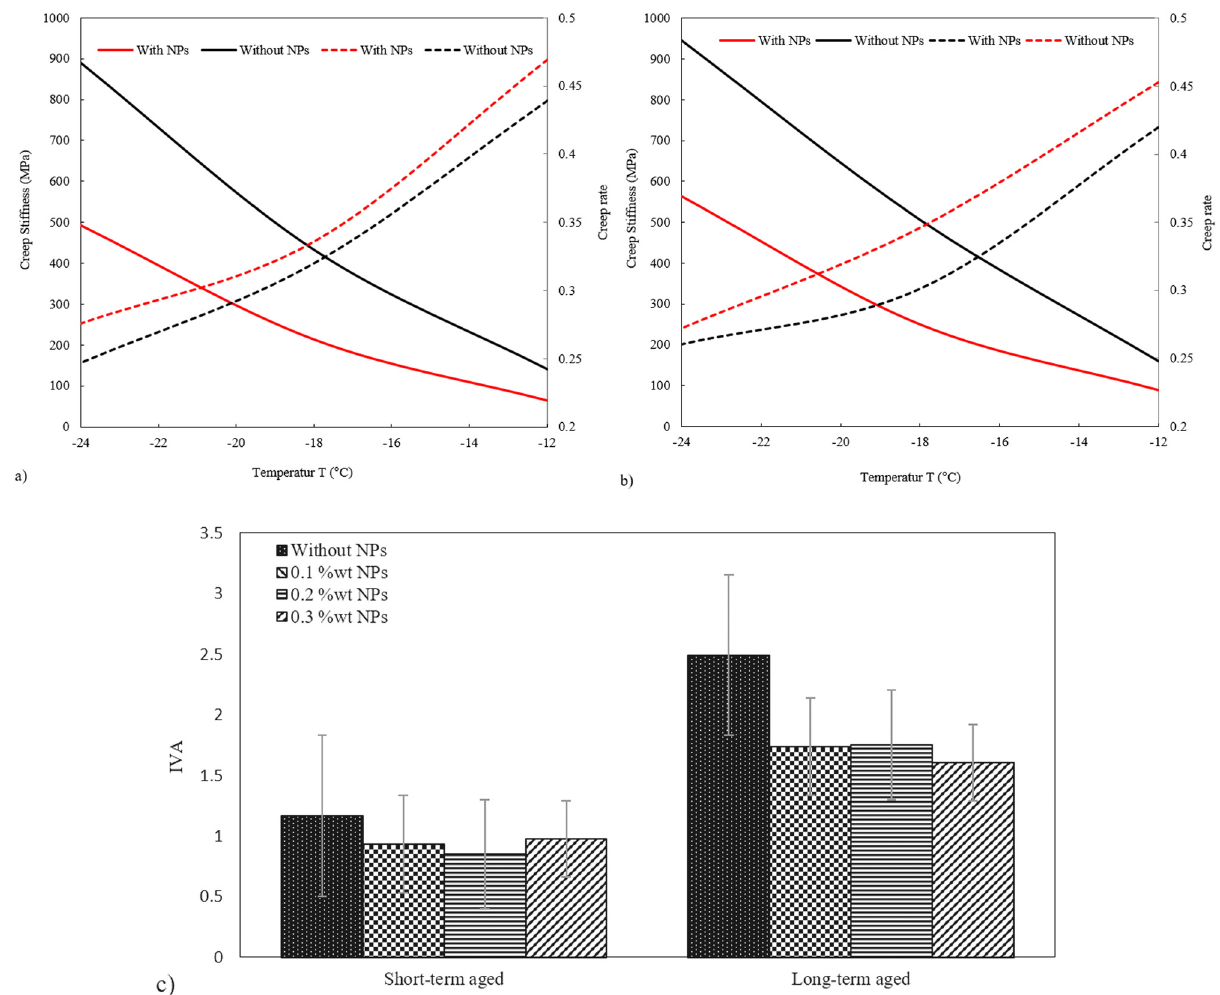
Figure 11: Creep sti ff nesses ( S ) and creep rates ( m - value ) of asphalt binders: ( a ) nonmodi fi ed and ( b ) modi fi ed by NPs after long - term aging at di ff erent temperatures. ( c ) IVA of base binder and NP - modi fi ed asphalt